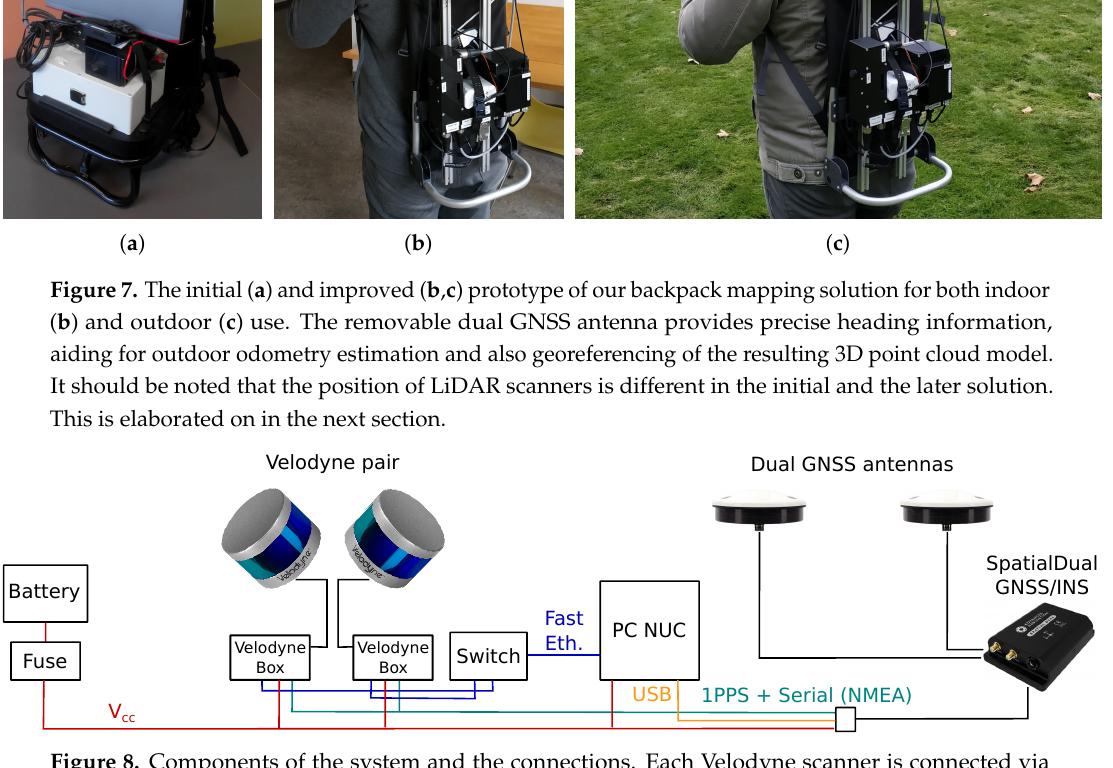
Figure 8. Components of the system and the connections. Each Velodyne scanner is connected via a custom wiring “box” requiring power supply (red wires), 1PPS and NMEA synchronization (green) and Fast Ethernet (blue) connection with computer (PC NUC in our